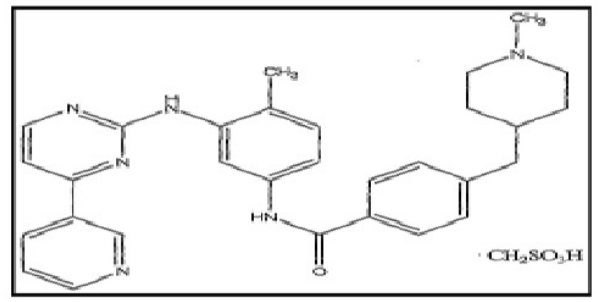
FIGURE 2 - The chemical structure of imatinib